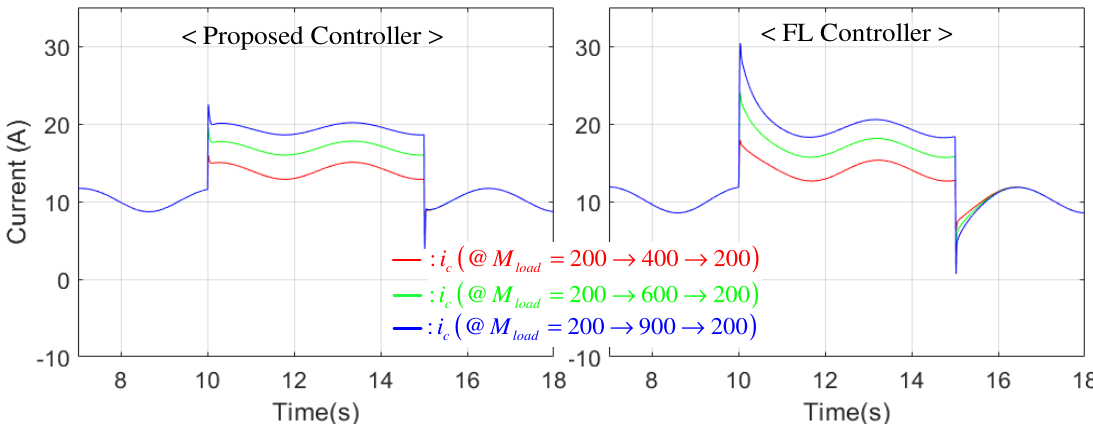
Figure 7. Current response comparison results for three load mass variation scenarios under external disturbances of f ext ,1 ( t ) .